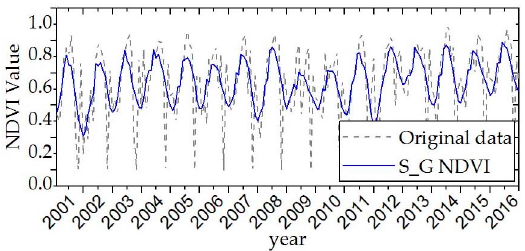
Figure 5. The maximum value of a fitted NDVI pixel decreased sharply in 2008 on the Daguangbao landslide in Anxian County, as a result of the 12 May Wenchuan Earthquake, and dropped again in 2009 and 2010, then increased gradually in the following years. Figure 6. The maximum value of a fitted NDVI pixel decreased slightly in 2009 and then increased gradually, which is located in the Xibeiqiao Village of Pengzhou City. This reflects the minor influence of the 12 May 2008 Wenchuan